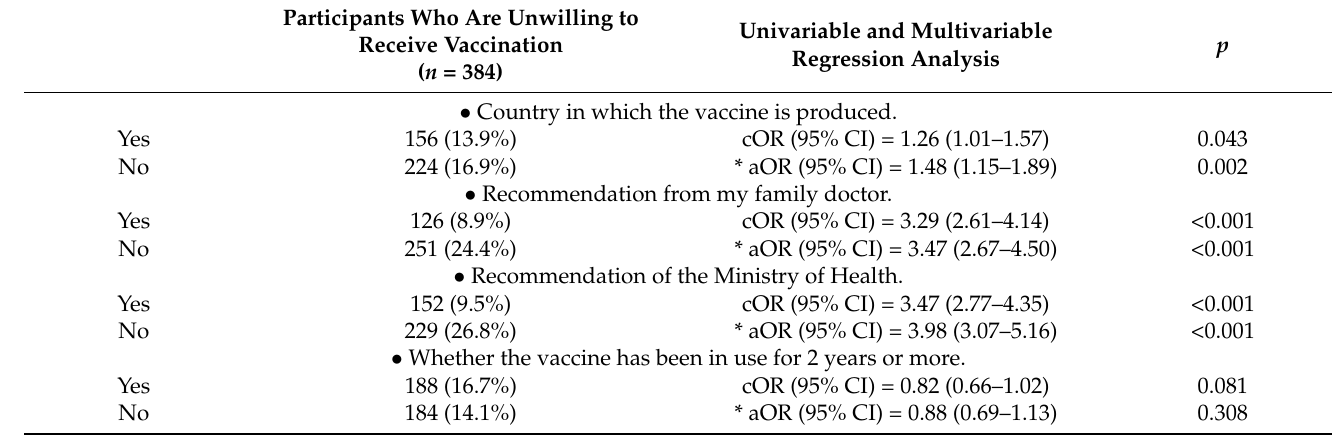
Table 5. Associations between perceptions and COVID-19 vaccination intention ( n =